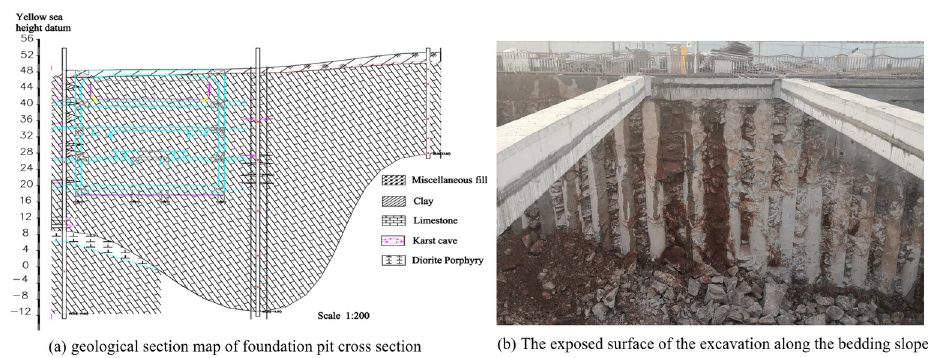
Figure 16. Engineering geological map.